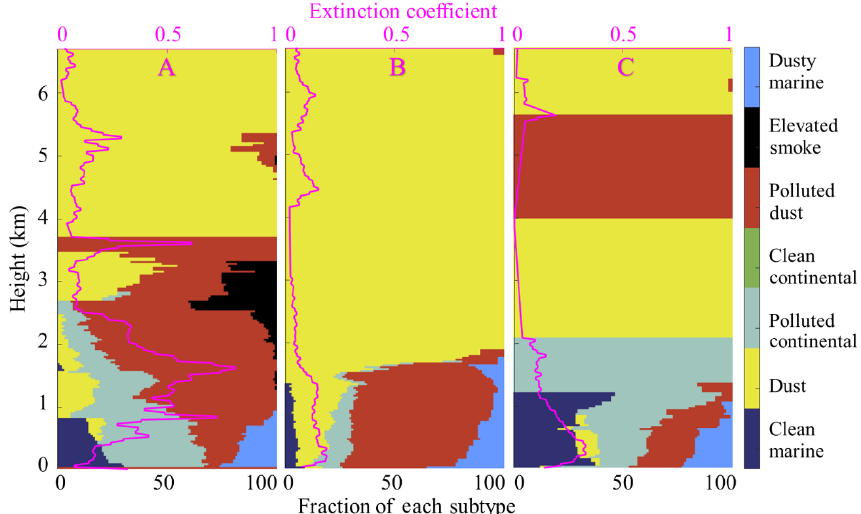
Figure 6. Vertical distributions of each aerosol subtype in region A, B, and C (see Fig. 5). Pink lines show profiles of average aerosol extinction coefficient (km − 1 ). The fraction is calculated as the occurrence of each subtype divided by the total occurrence of aerosols in each